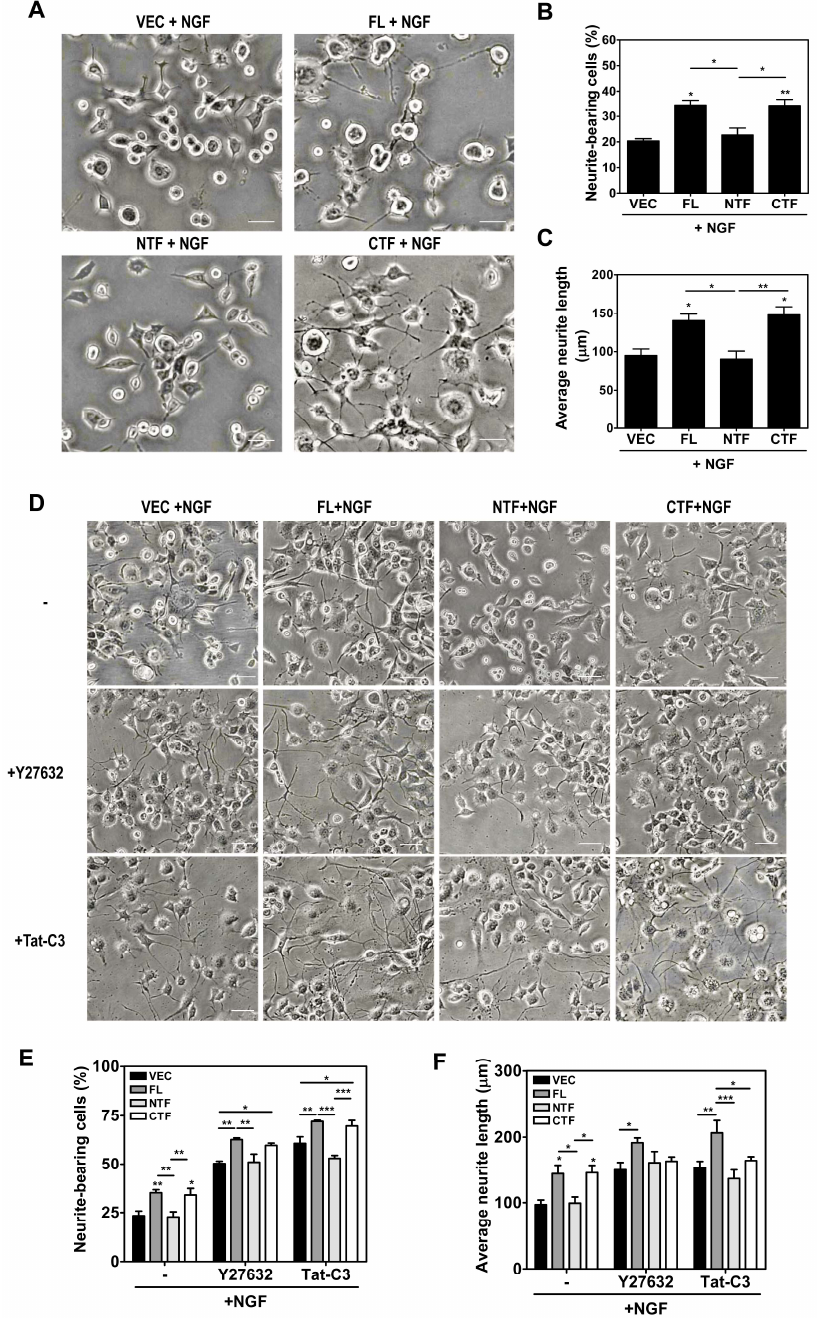
Figure 7. Overexpression of calsenilin FL and CTF enhanced neurite outgrowth by decreasing RhoA activity and RhoA-mediated signaling. ( A – C ) Morphological changes in PC12 cells expressing VEC, calsenilin FL, -NTF, or -CTF treated with 50 ng/mL NGF 2.5S for 72 h. All values are expressed as the mean ± SEM of three independent experiments. Statistical differences were determined by one-way ANOVA test with Tukey’s post hoc test ( n = 10–20 cells per treatment group, * p < 0.05; ** p < 0.01); ( D – F ) The cells were incubated with or without 10 μM Y27632 and 1 μg Tat-C3 for 72 h after NGF treatment. The number of neurites per cell was determined by counting all the processes longer than two cell diameters in length. The changes in neurite outgrowth were measured by using INFINITY analysis software. The data represent the mean ± SEM of three independent experiments. Statistical data were obtained by two-way ANOVA with Bonferroni’s post hoc test ( n = 10–20 cells per treatment group, * p < 0.05; ** p < 0.01; *** p < 0.001). Scale bars, 100 μm.